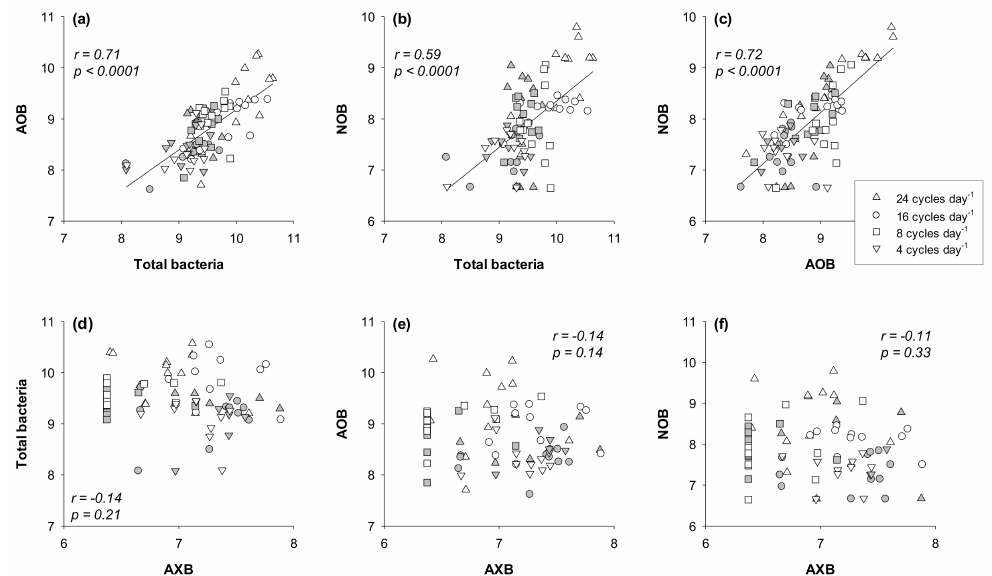
Figure 4. Pairwise comparisons of the log abundance of total bacteria, ammonium oxidizing bacteria (AOB), nitrite oxidizing bacteria (NOB), and anammox bacteria (AXB) for each sample analyzed in this study. The r values are Pearson correlation coefficients. Symbol shapes indicate the cycling treatment, open symbols represent the High-N reactor, and shaded symbols represent the Low-N